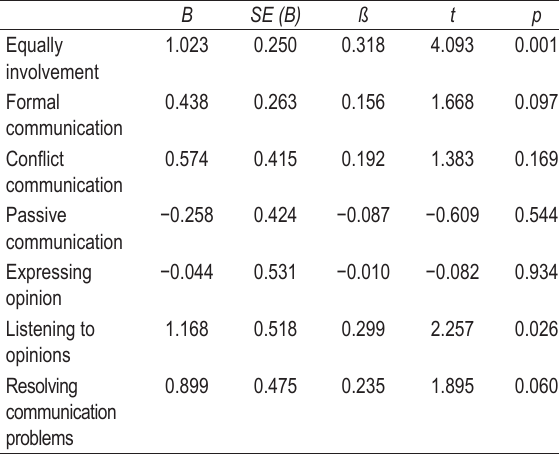
TABLE 5. Influence of individual team communication on team participation ‑ Multiple regression model